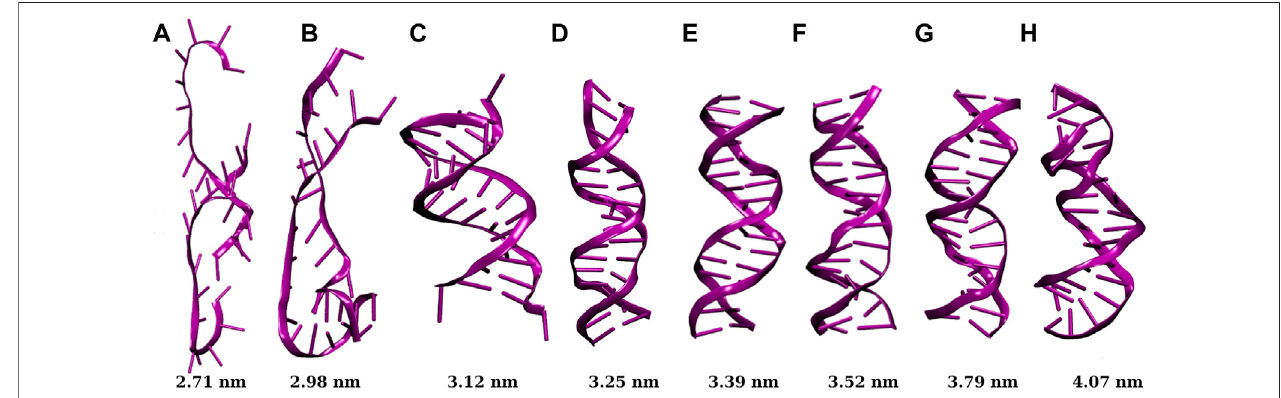
FIGURE 2 | Snapshots of dsDNA con fi ned inside SWCNTs of different chirality indices, where (A,B,C,D,E,F,G,H) correspond to chirality indices (20,20), (22,22), (23,23), (24,24), (25,25), (26,26), (28,28), and (30,30) respectively. The value below each snapshot is the diameter of the corresponding SWCNT. Below chirality indices (24,24) or 3.25 nm diameter of SWCNT, the dsDNA gets denatured with a signi fi cant cut-off of H-bonds.